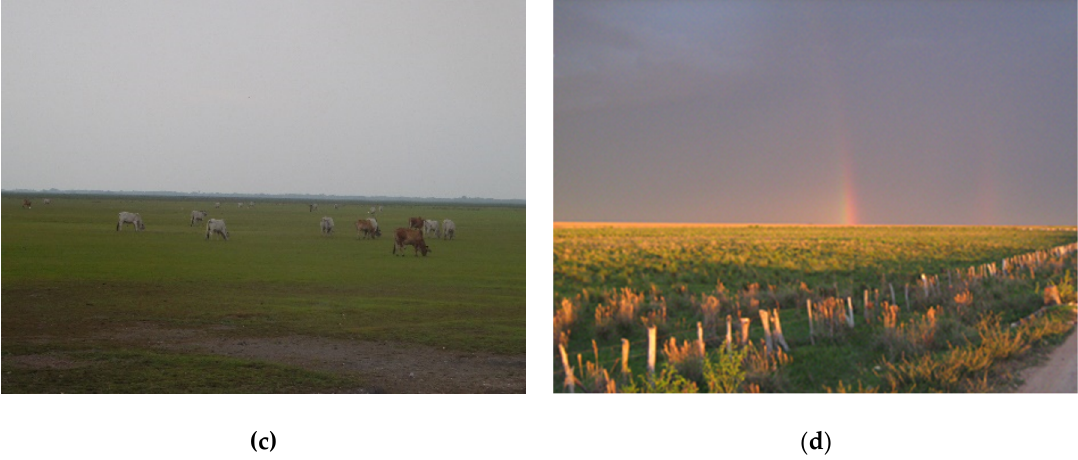
Figure 2. Examples of cattle grazing and burning management in the study site: ( a ) savanna with lignified grassland dominated by Andropogon bicornis (graminoid); ( b ) controlled burning to promote re-growth of savanna vegetation; ( c ) cattle grazing in post-burn vegetation; ( d ) savanna vegetation recovery five months after burning and before the start of the rainy season.